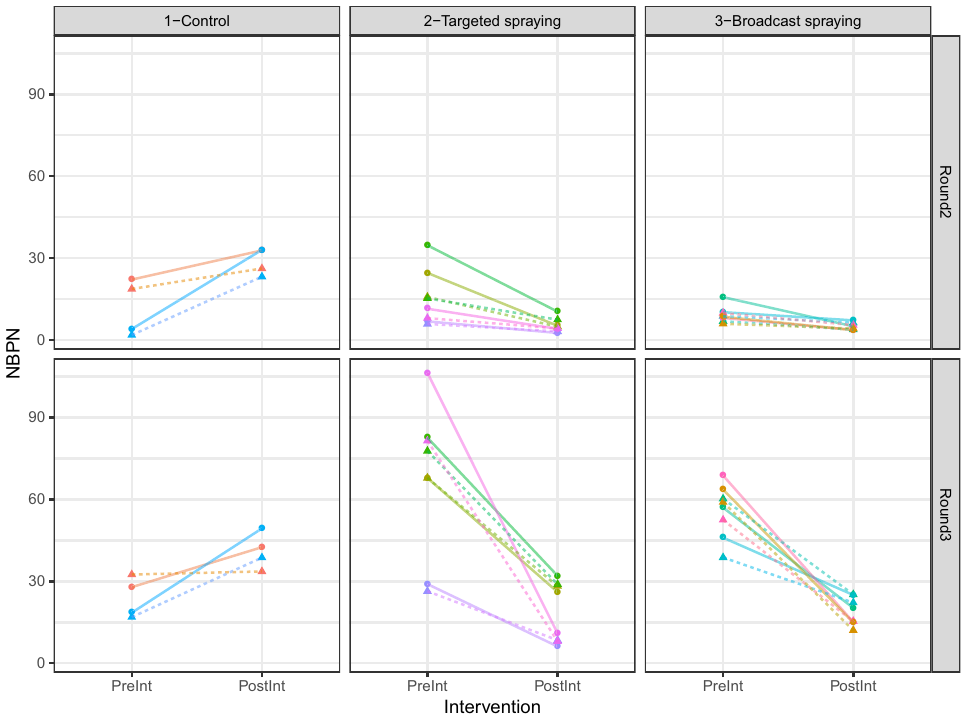
Figure 5. Plot of the raw NBPN data; stratified by intervention type (columns: control, targeted spraying, and broadcast spraying) and round (rows). Each village is assigned a unique color, and the change in NBPN between pre- and post-intervention measurements is plotted as a line. We found significant negative main effects of targeted spraying and broadcast spraying on NBPN (p-value = 0.037 and p-value = 0.026,